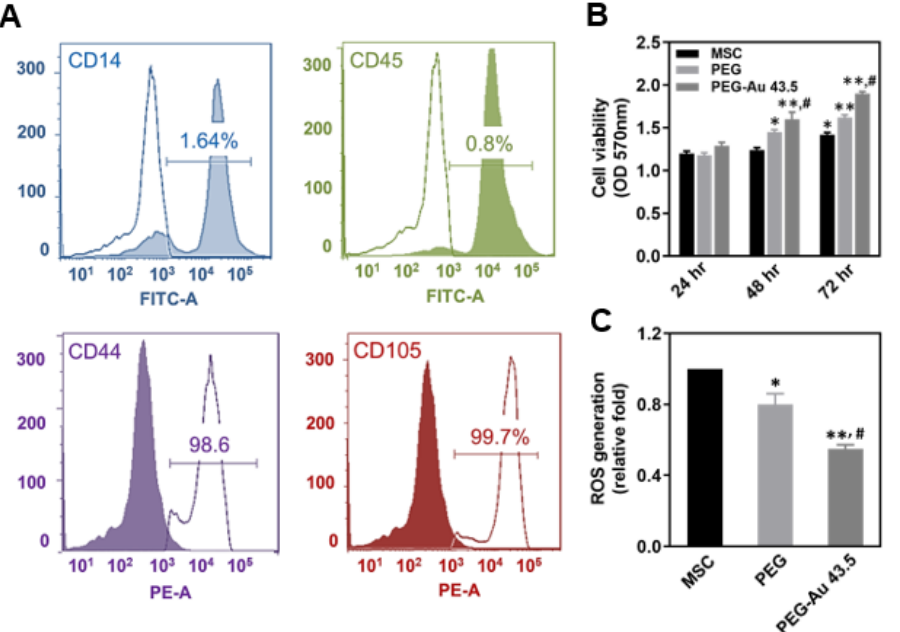
Figure 2. Phenotype characterization and biocompatibility assessments of MSCs. ( A ) The antibodies were first conjugated with Fluorescein Isothiocyanate (FITC) and Phycoerythrin (PE), with the following markers being CD14-FITC, CD45-FITC, CD44-PE, and CD105-PE. Next, the surface antigens of MSCs were analyzed by flow cytometry. ( B ) The cell viability of MSCs after culturing on pure PEG and PEG – Au 43.5 ppm at various time periods (24, 48, 72 h) were investigated by MTT assay. The cell viability was greatest at 72 h in the PEG – Au 43.5 ppm group compared to the control group. Data are expressed as mean ± SD (n = 6). * p < 0.05, ** p < 0.01: compared to the MSC alone group. # p < 0.05: compared to the pure PEG group. All the results are representative of one of six independent experiments. ( C ) The intracellular ROS generation of MSCs culturing on pure PEG and PEG – Au 43.5 ppm was detected through 2,7-dichlorofluorescein diacetate (DCFH-dA) and analyzed by flow cytometry. The results were semi-quantified. Data are represented as mean ± SD (n = 3). * p < 0.05, ** p < 0.01: compared to the MSC alone group. # p < 0.05: compared to the pure PEG group. All the results are repre- sentative of one of three independent experiments.